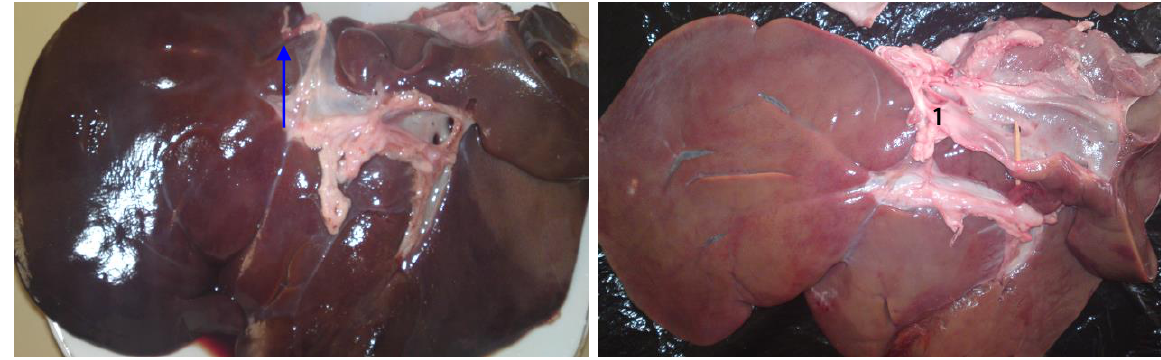
Figure, 1: Right dorsal and right branches of portal vein in sheep